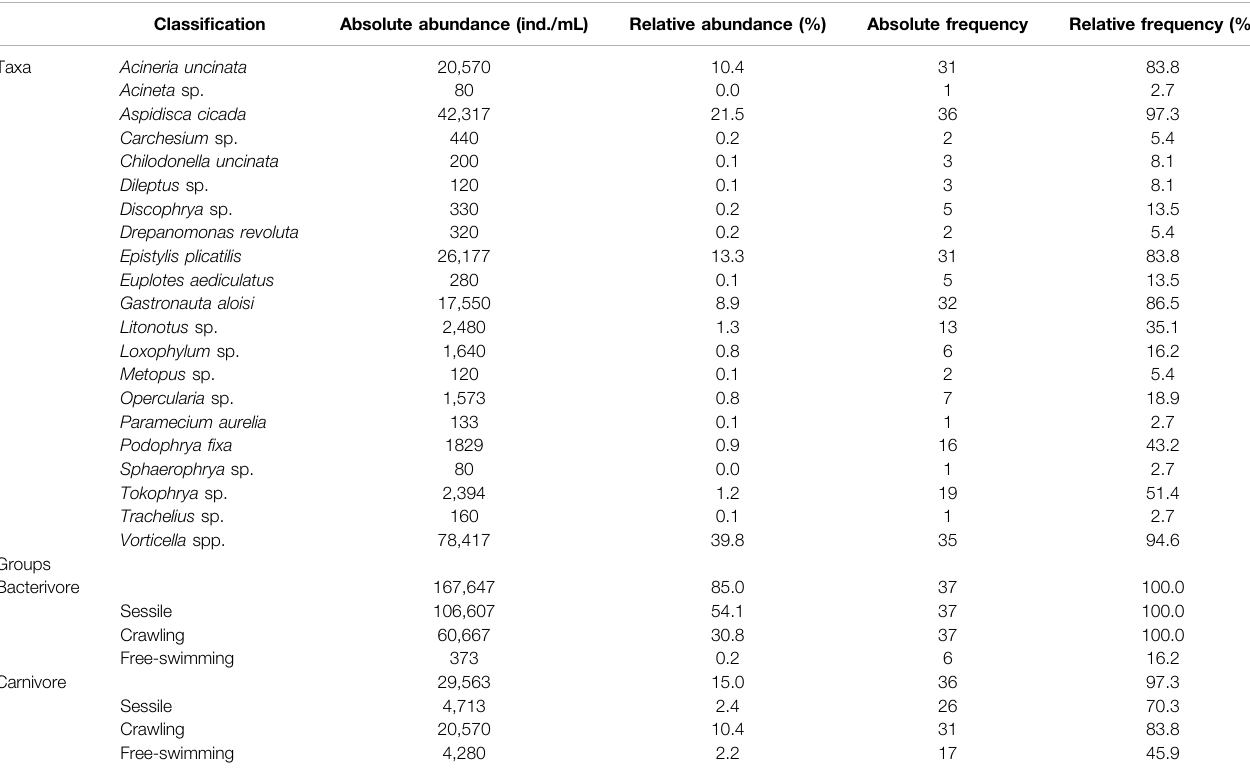
TABLE 1 | Absolute and relative abundance and frequency of active ciliates found in the Piçarrão WWTP throughout the 37-sampling period. Classi fi cation Absolute abundance (ind./mL) Relative abundance (%) Relative frequency